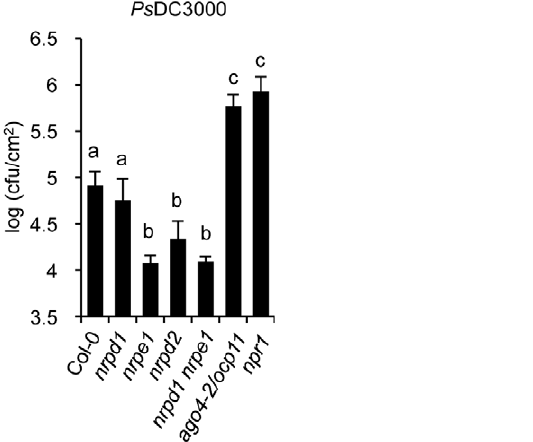
Figure 6. Comparative immune responses of Pol IV and Pol V defective mutants to inoculation with Pseudomonas syringae DC3000. Growth rates of Ps DC3000 in Col-0, nrpd1 , nrpe1 , nrpd2 , and nrpd1 nrpe1 plants. The Ps DC3000 disease susceptible mutants ago4-2/ ocp11 and npr1 were included for comparison. Data represent the mean 6 SD; n=3 biological replicates.